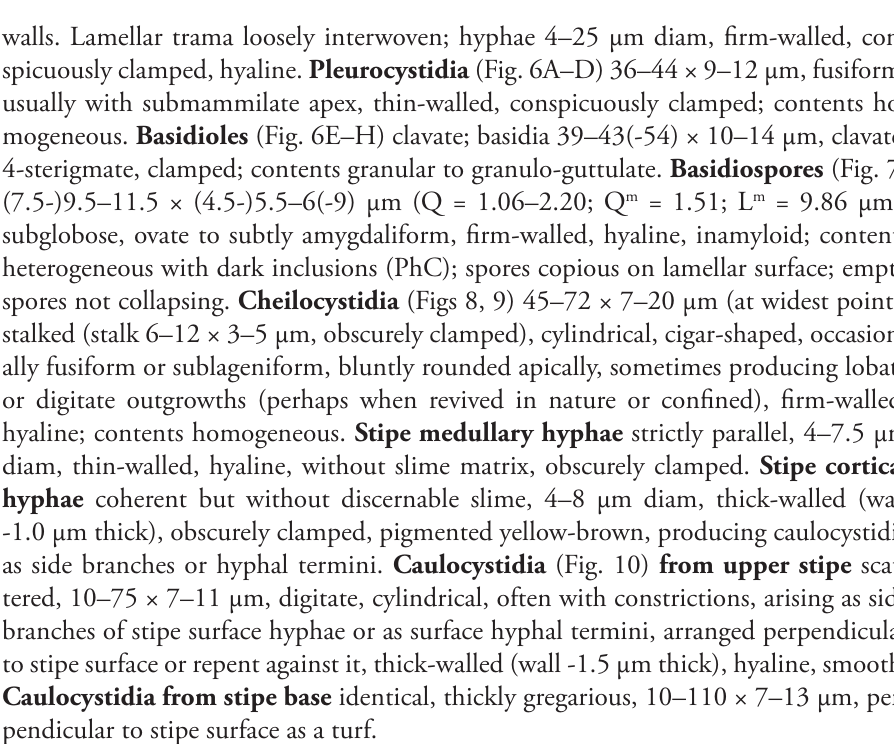
Figure 7. Mycetinis alliaceus. Basidiospores. Standard bar = 5 µm. TFB 11451